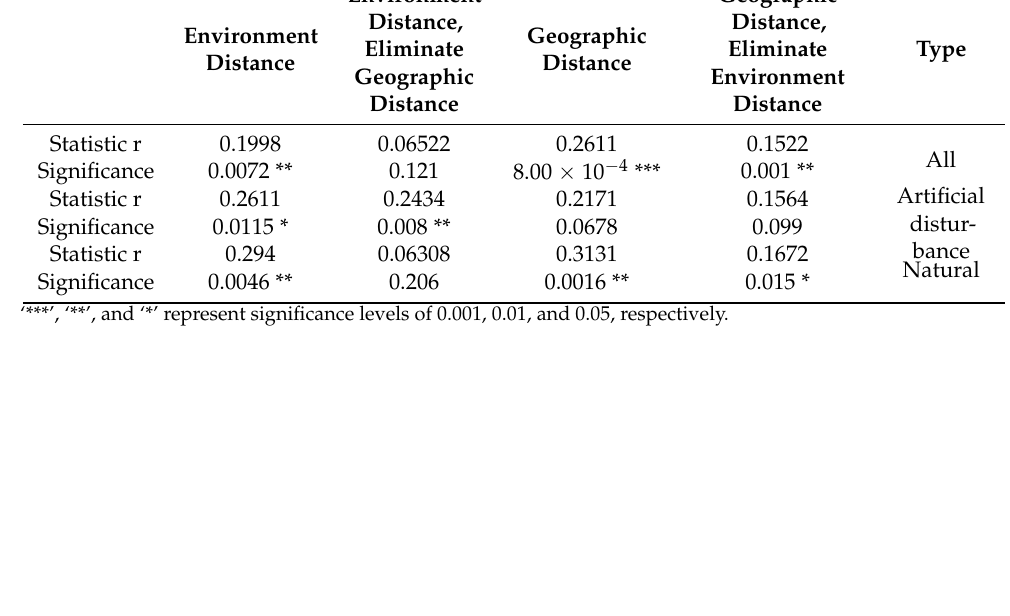
Table 4. Mantel and partial Mantel test between β-diversity and environment/geographic distance.